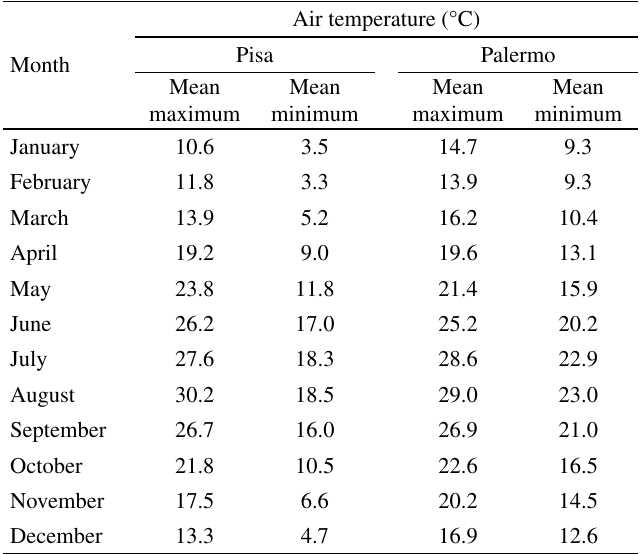
Table 1 - Monthly mean air temperatures (°C) during the trial period (2011) at Pisa and Palermo